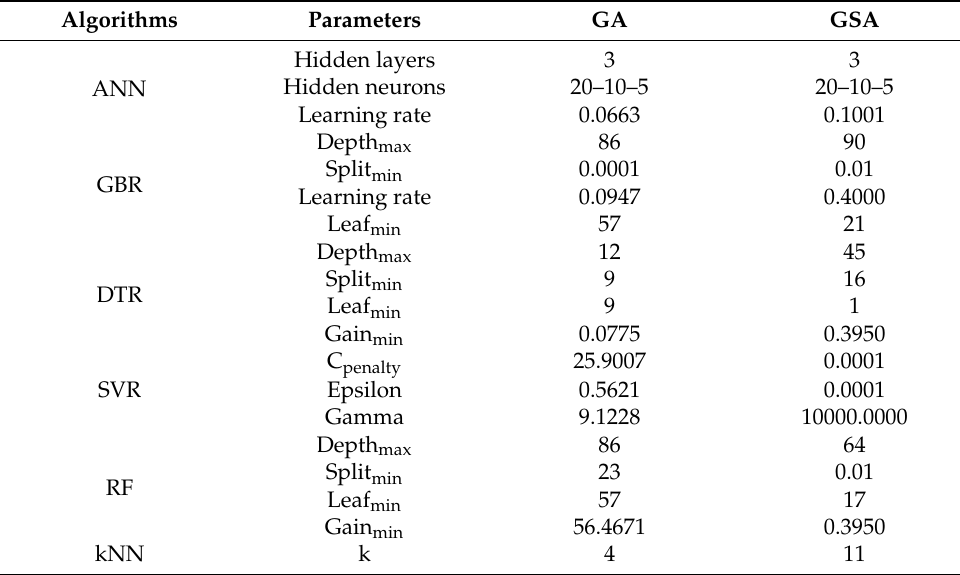
Figure 3. R 2 and RMSE value of ML models with ( a ) GBR; ( b ) DTR; ( c ) RF; ( d ) SVR; ( e ) kNN; ( f ) ANN, tuned by GA. Table 5. Tuned parameters of six types of ML models utilising GSA and